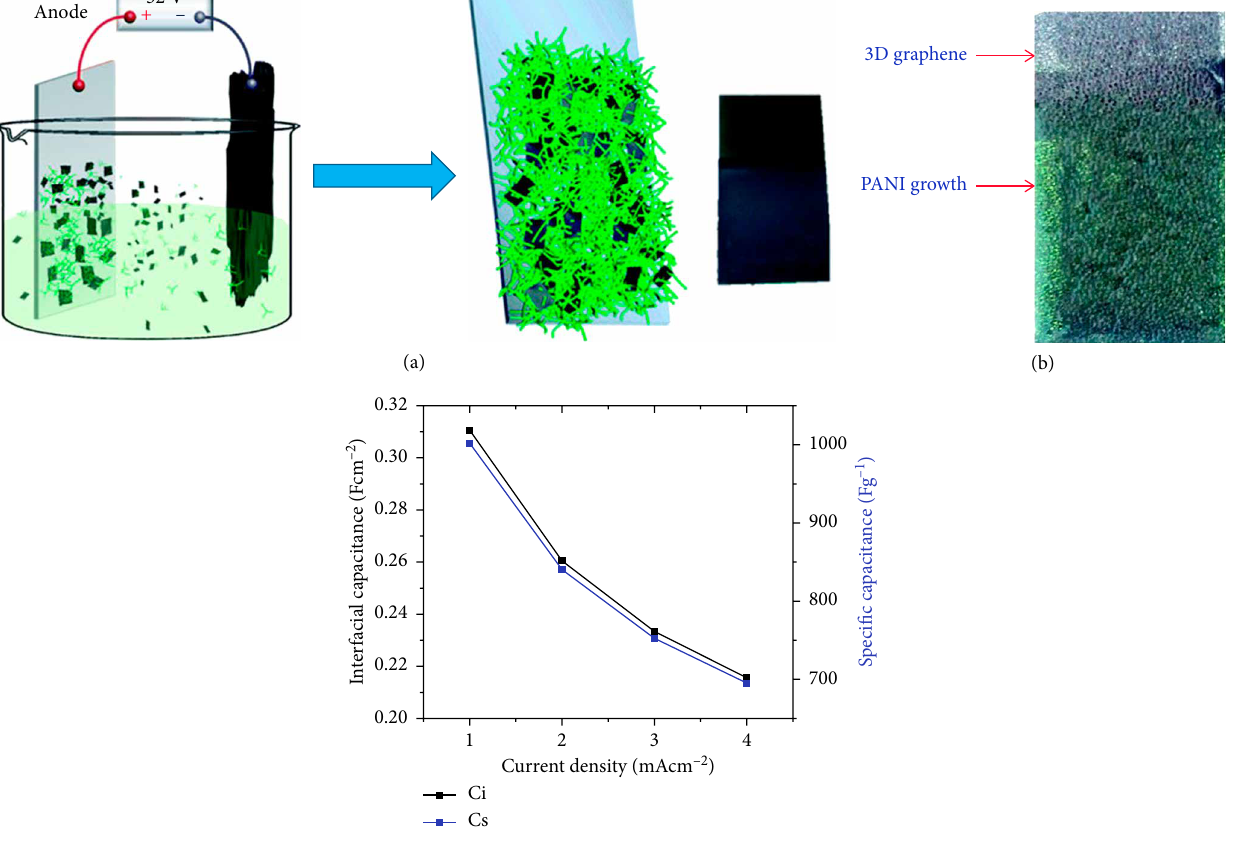
Figure 7: (a) Schematic illustration of the electrophoretic deposition preparation of MoS from [135]. (b) Optical image of 3D graphene/PANi supercapacitor electrode. Adapted from [134]. (c) Specific capacitance of 3D graphene/ PANi is related to the current density. Adapted from